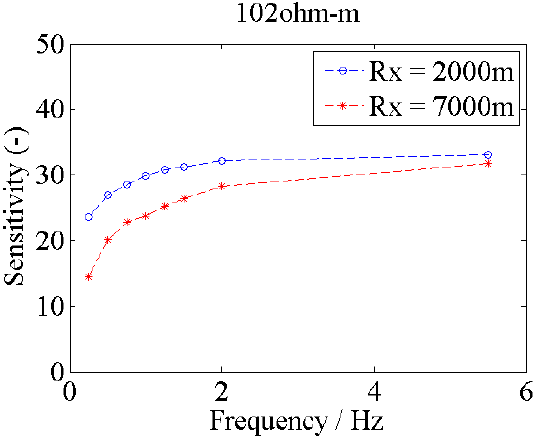
Figure 4. CSEM sensitivity study result related to frequency.